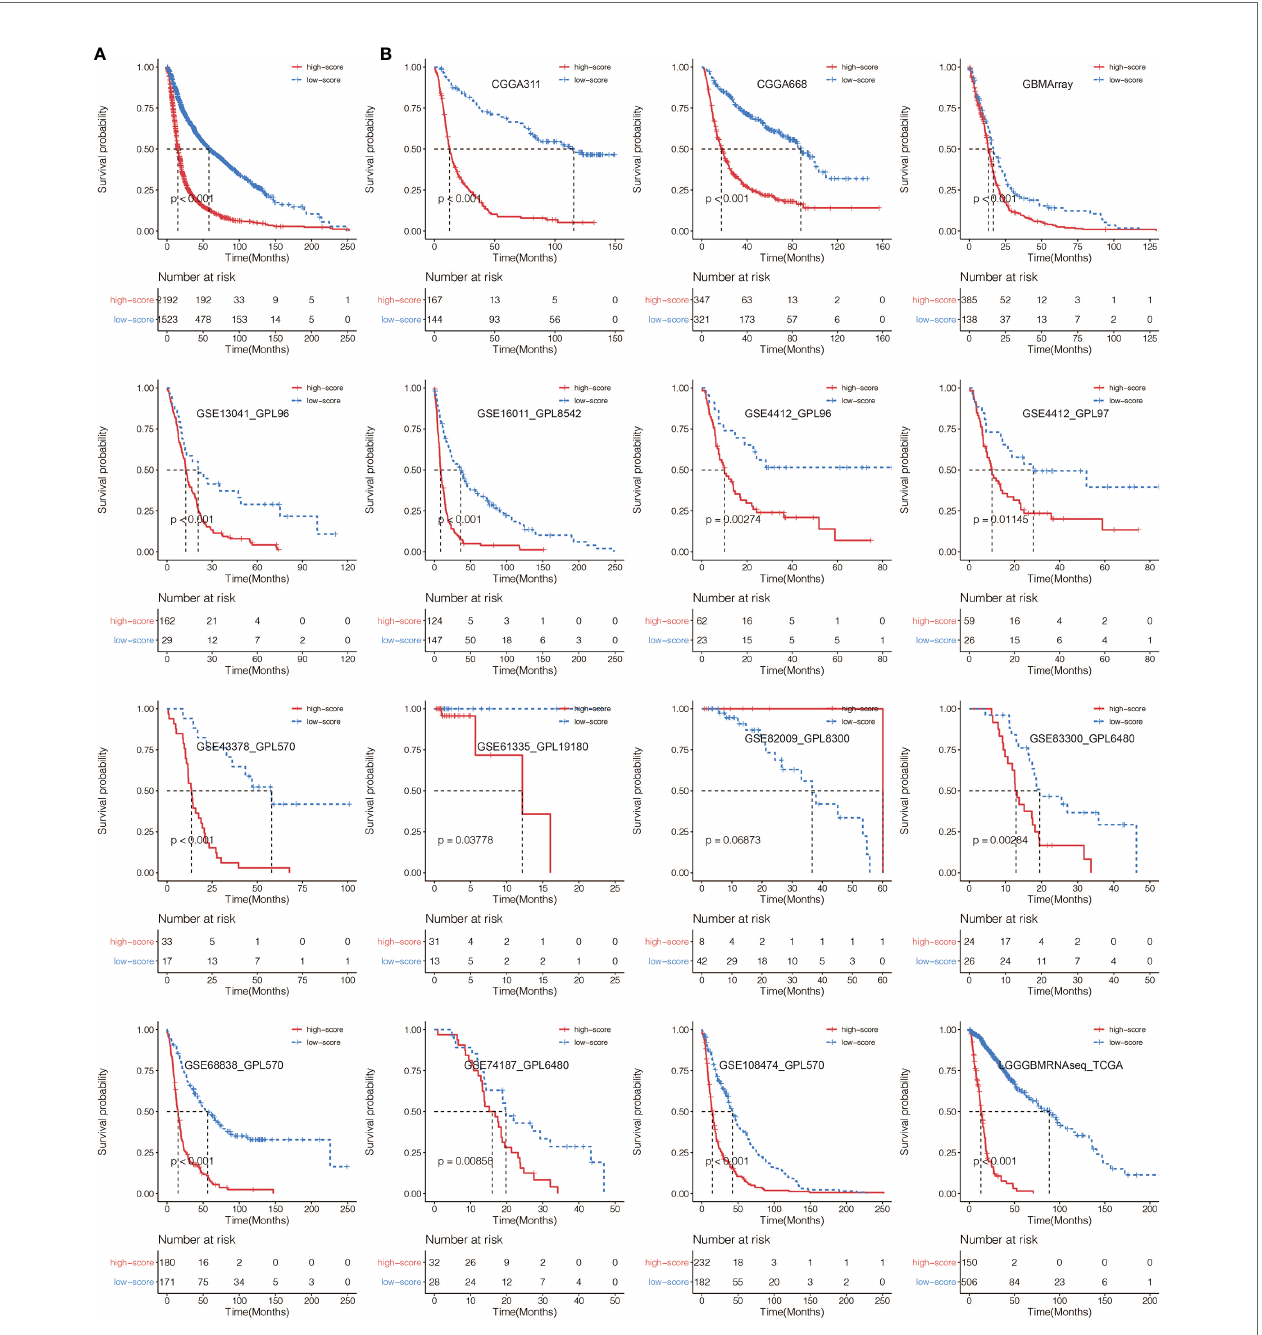
FIGURE 2 | (A) Kaplan – Meier curves for the two ICP score groups in all glioma samples. Log-rank test, P < 0.001. (B) Kaplan – Meier curves for the two ICP score groups in all collected glioma datasets. Log-rank test, P <